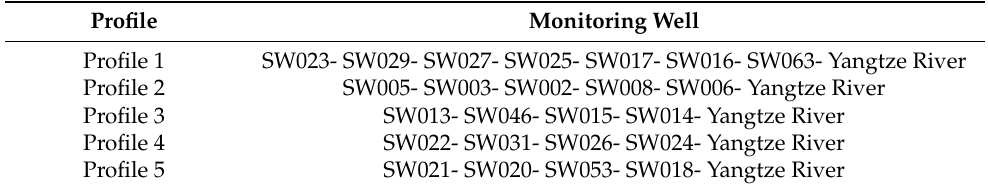
Table 1. Distribution of monitoring wells on each